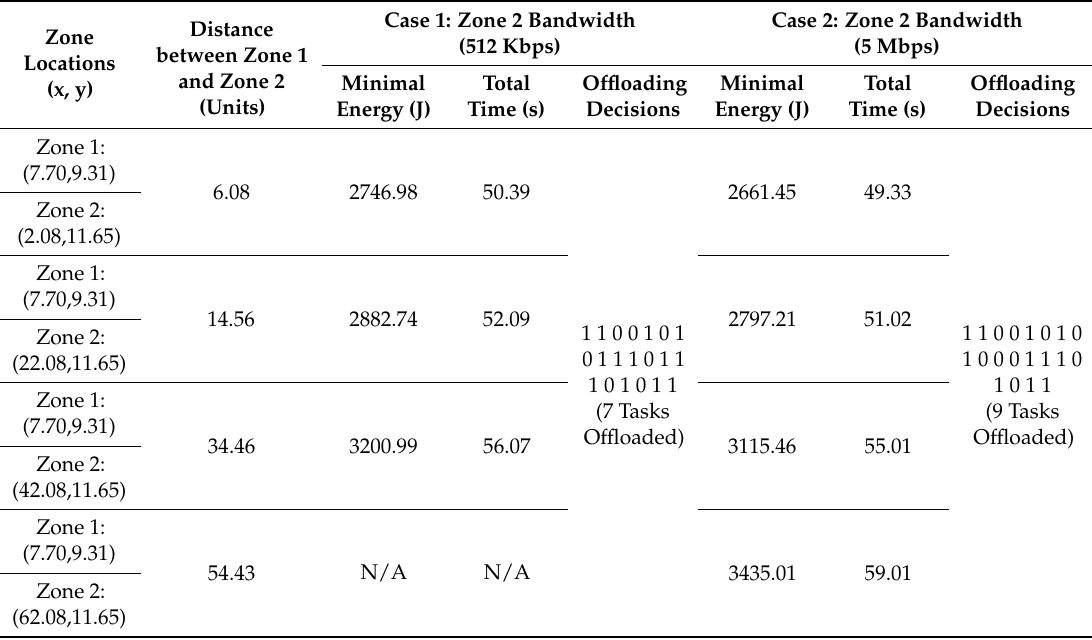
Table 6. Impact of movement on offloading decisions and system